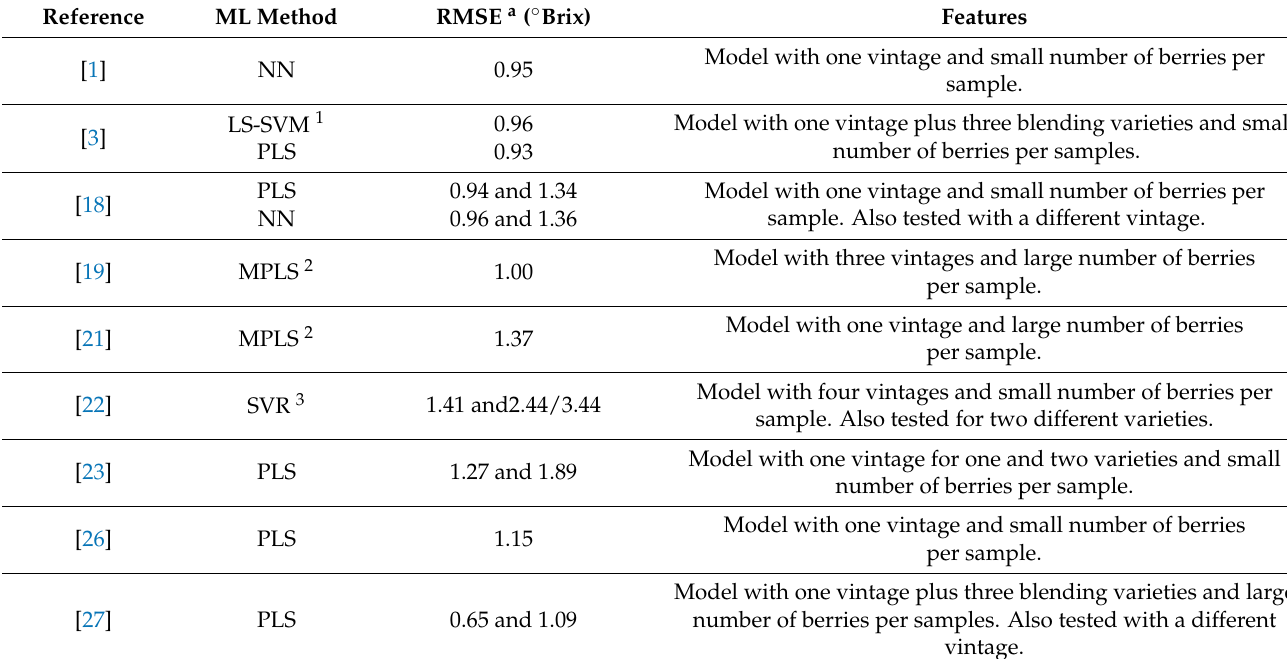
Table 1. Works measuring sugar content in grape berries using spectroscopic techniques in reflectance mode combined with machine learning